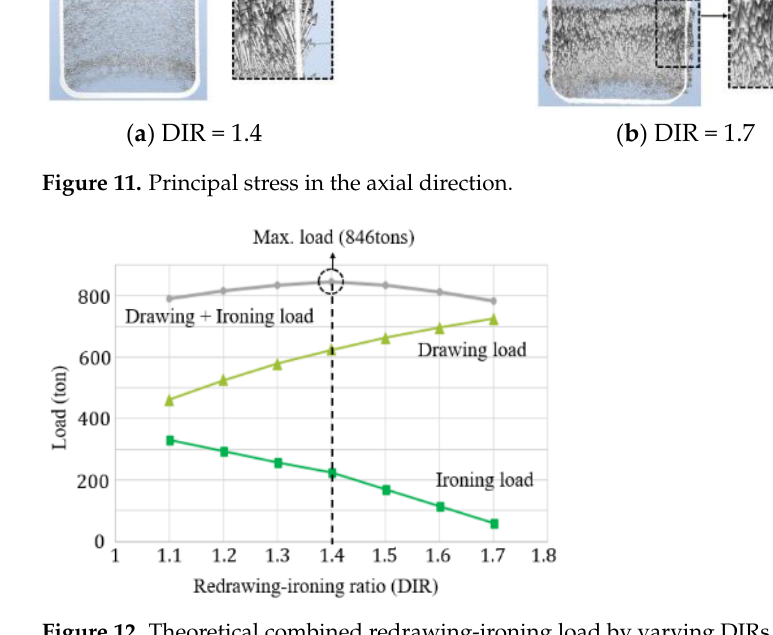
Figure 12. Theoretical combined redrawing-ironing load by varying DIRs.